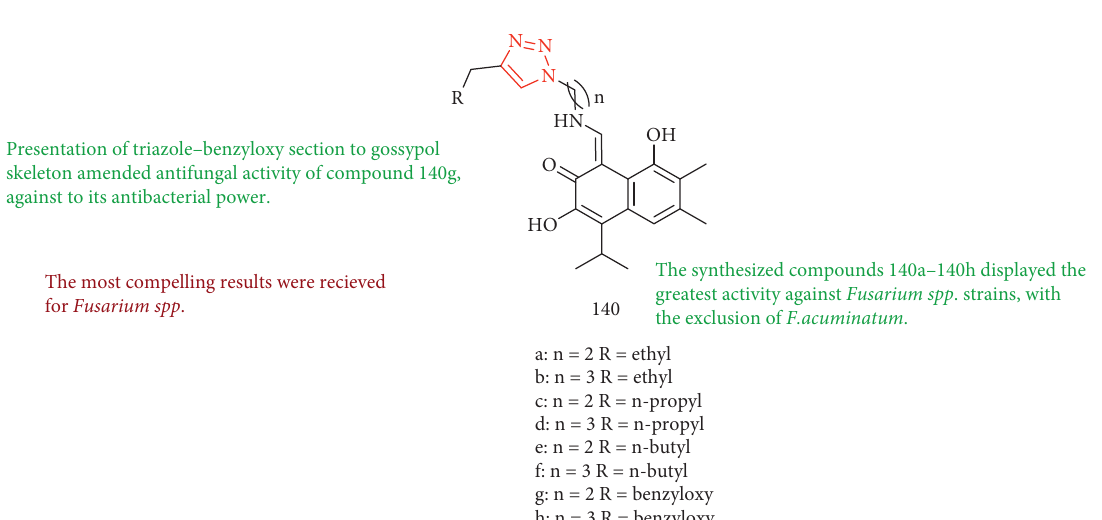
Figure 72: Chemical structure of novel 1,2,3-triazole-functionalized strobilurins.